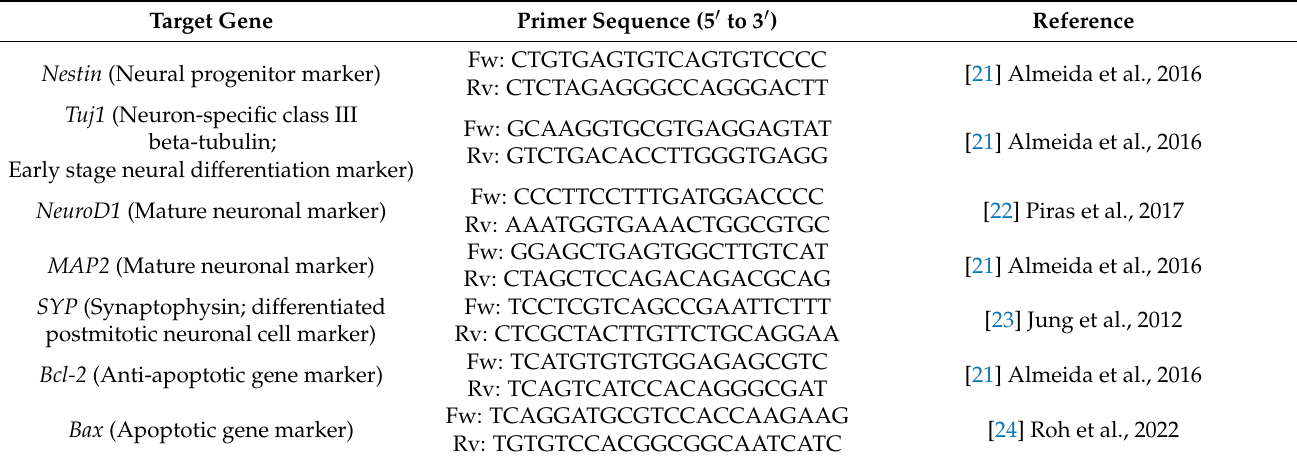
Table 1. List of primer sets for assessment of cell maturation, proliferation and survival. Target Gene Primer Sequence (5 (cid:48) to 3 (cid:48)